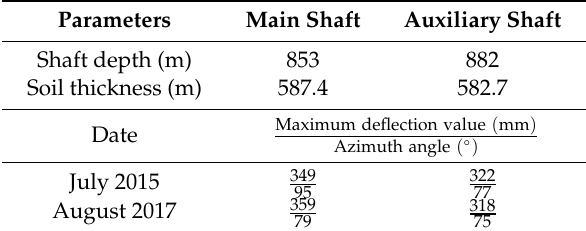
Table 2. Design parameters and deflective situations of shafts in the Guotun Coal